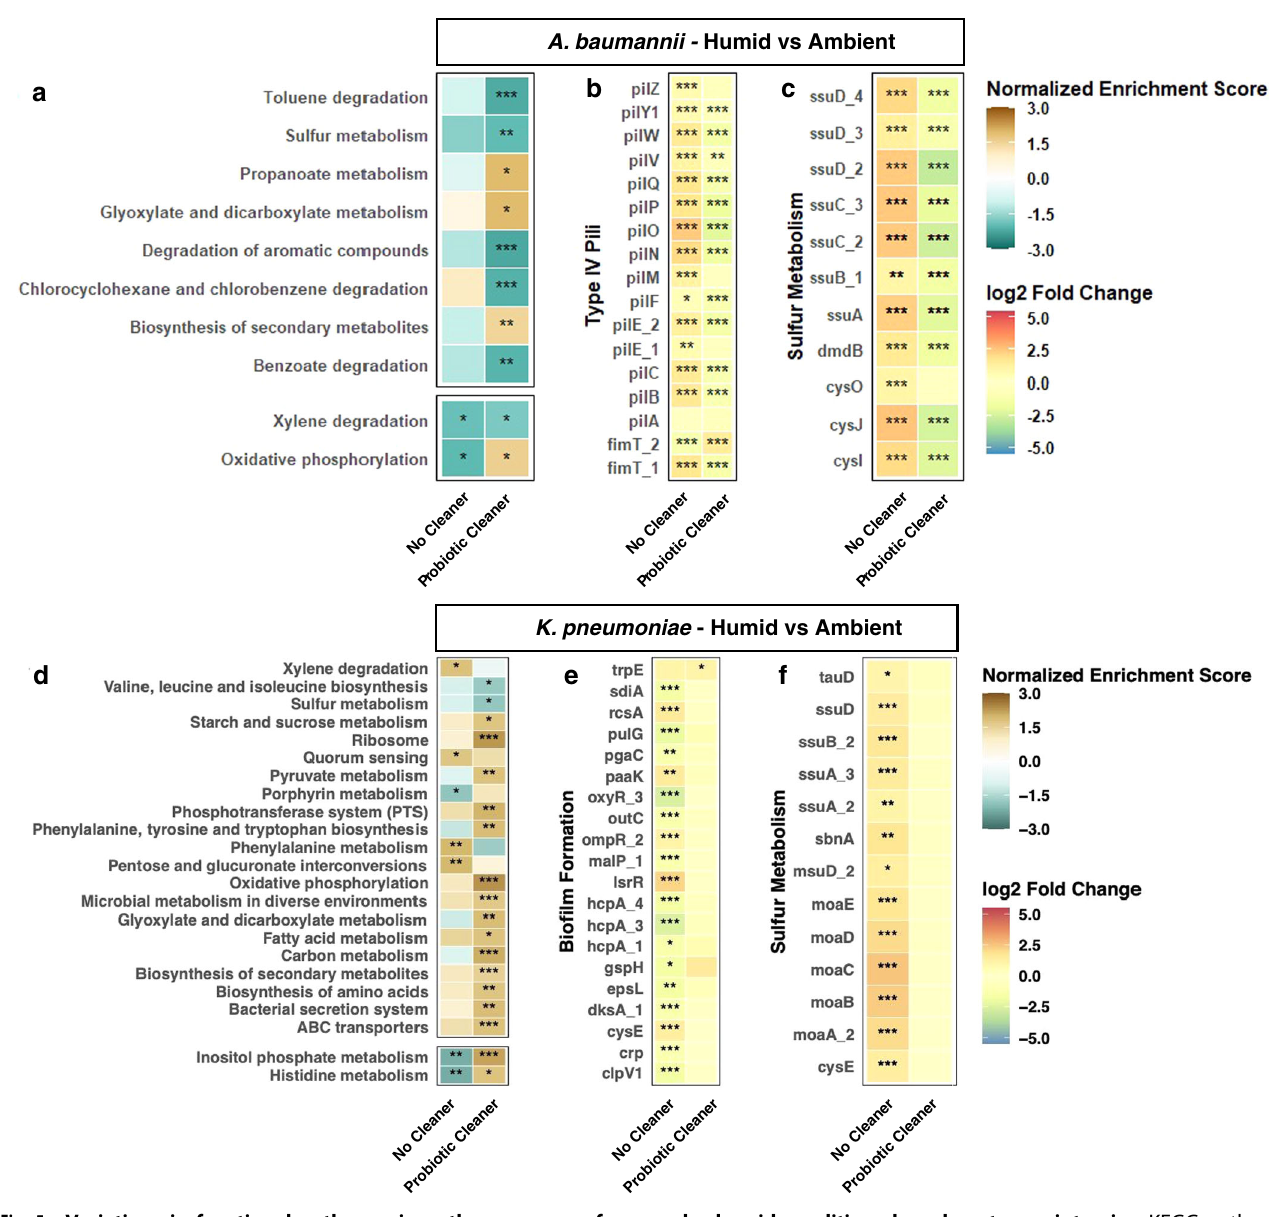
Fig. 5 Variations in functional pathways in pathogens on surfaces under humid conditions based on transcriptomics. KEGG pathway enrichment results for No Cleaner and Probiotic Cleaner samples collected under elevated temperature and humidity condition ( a , d ), log 2 fold change of genes associated with A. baumannii cell motility ( b ), K. pneumonia e bio fi lm formation ( e ), and sulfur metabolism ( c , f ). KEGG pathways shown here were statistically enriched in at least one of the cleaning conditions (Benjamini-Hochberg corrected p value ≤ 0.05). * p < 0.05, ** p < 0.01, *** p <